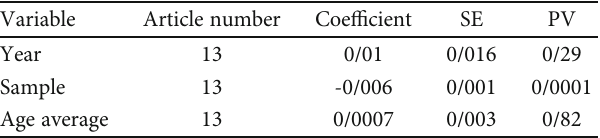
Table 5: Results of